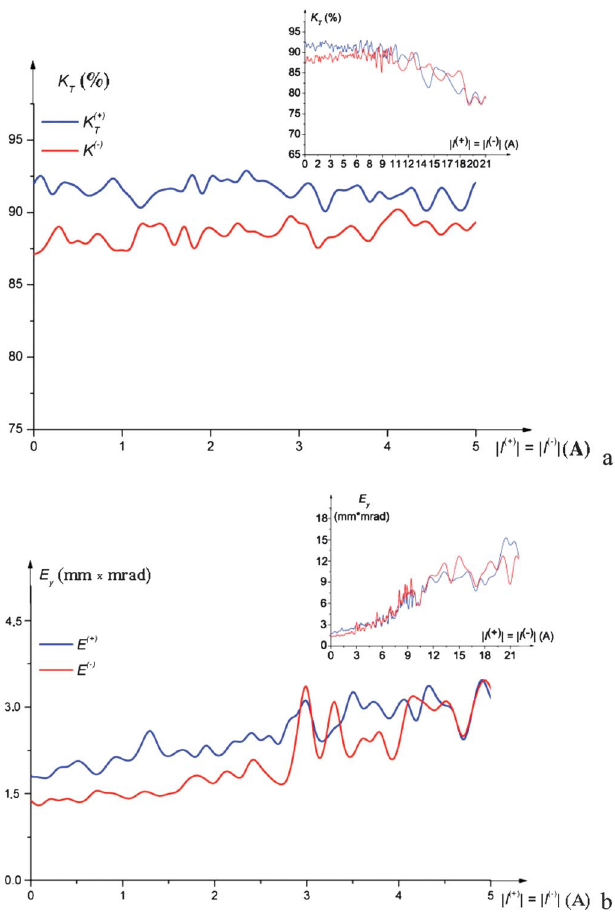
FIG. 9. (Color) The current transmission coefficient (a) and the transverse beam emittance (b) versus the total initial beam